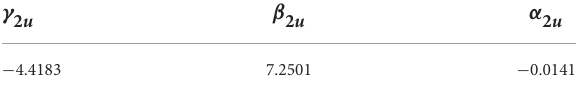
TABLE 8 Parameters estimates of the time-varying model for the upper-tail-dependence coefficients λ U 2 m .